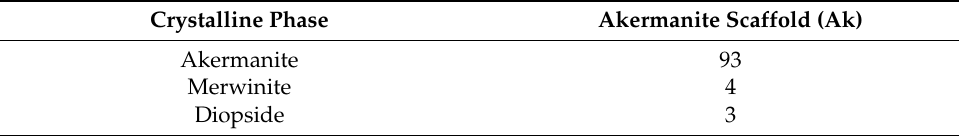
Figure 17. X-ray patterns of akermanite scaffolds. Table 7. Quantification analysis of akermanite scaffolds in %.